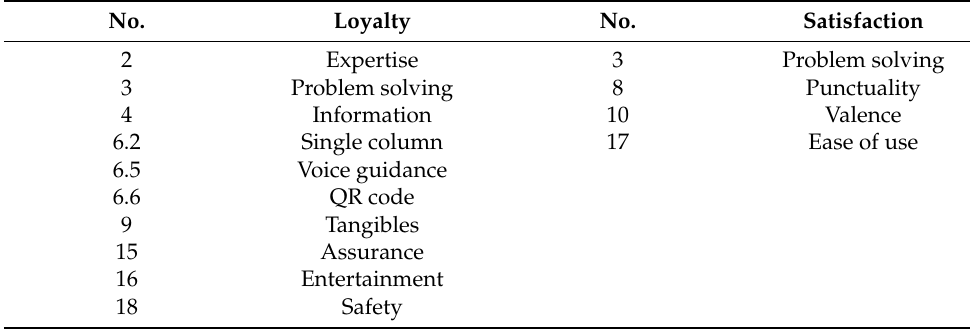
Table 9. Factor comparison between loyalty and